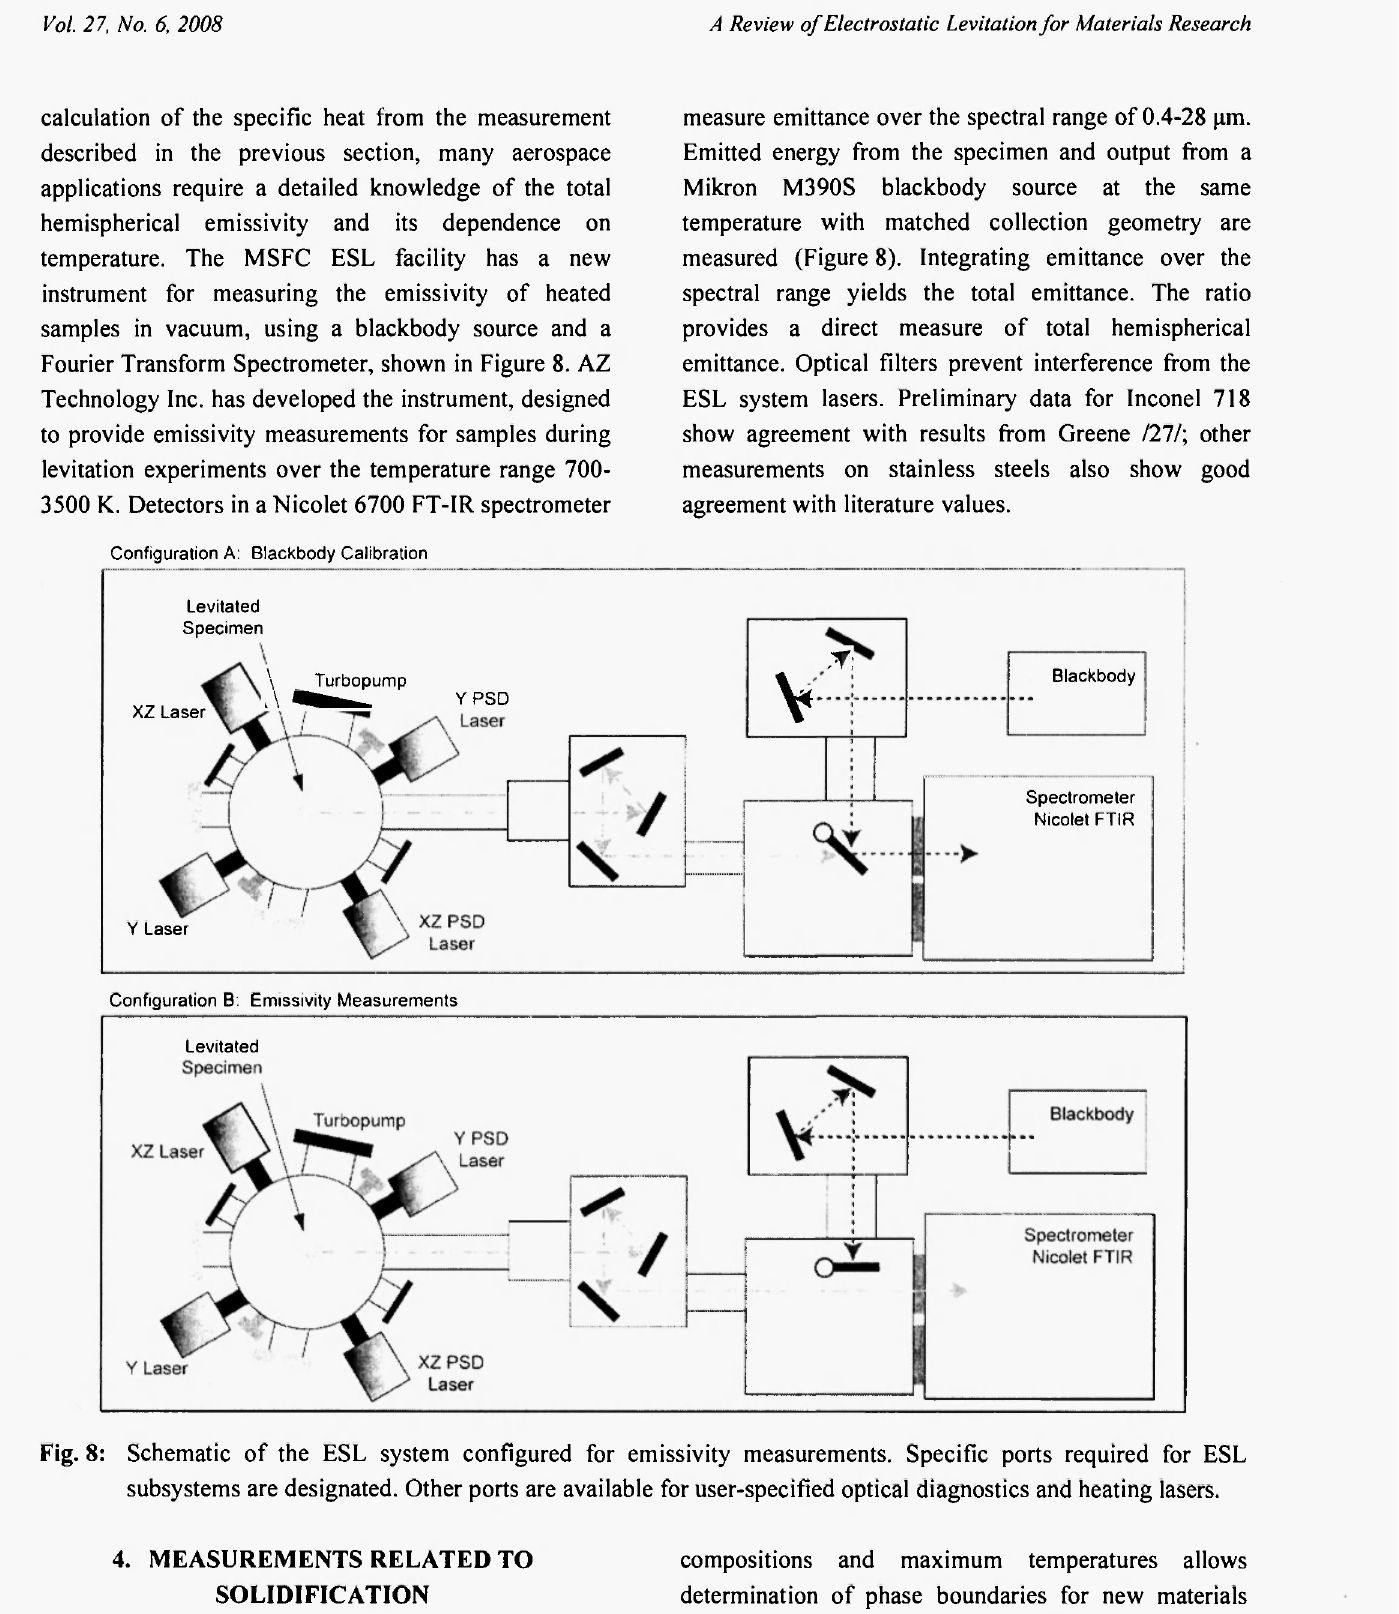
Fig. 8: Schematic of the ESL system configured for emissivity measurements. Specific ports required for ESL subsystems are designated. Other ports are available for user-specified optical diagnostics and heating